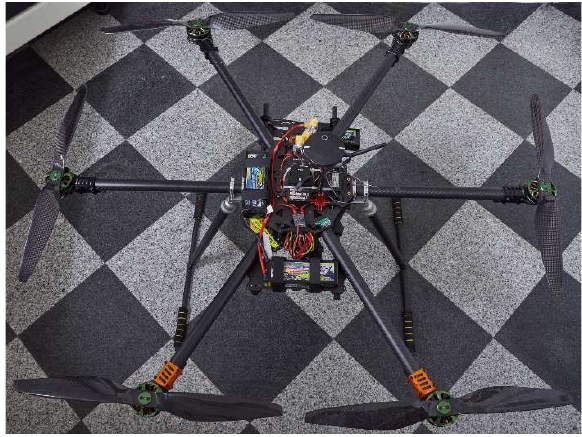
Figure 9. The finished survey